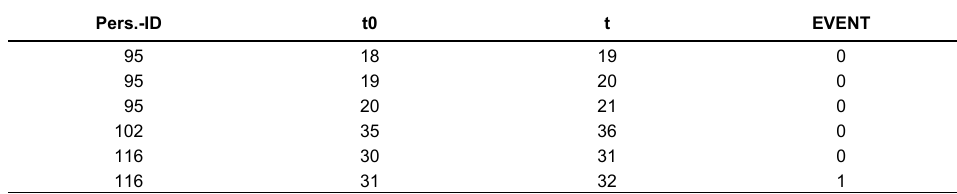
Tab. 2: Datensatz nach Aufbereitung als